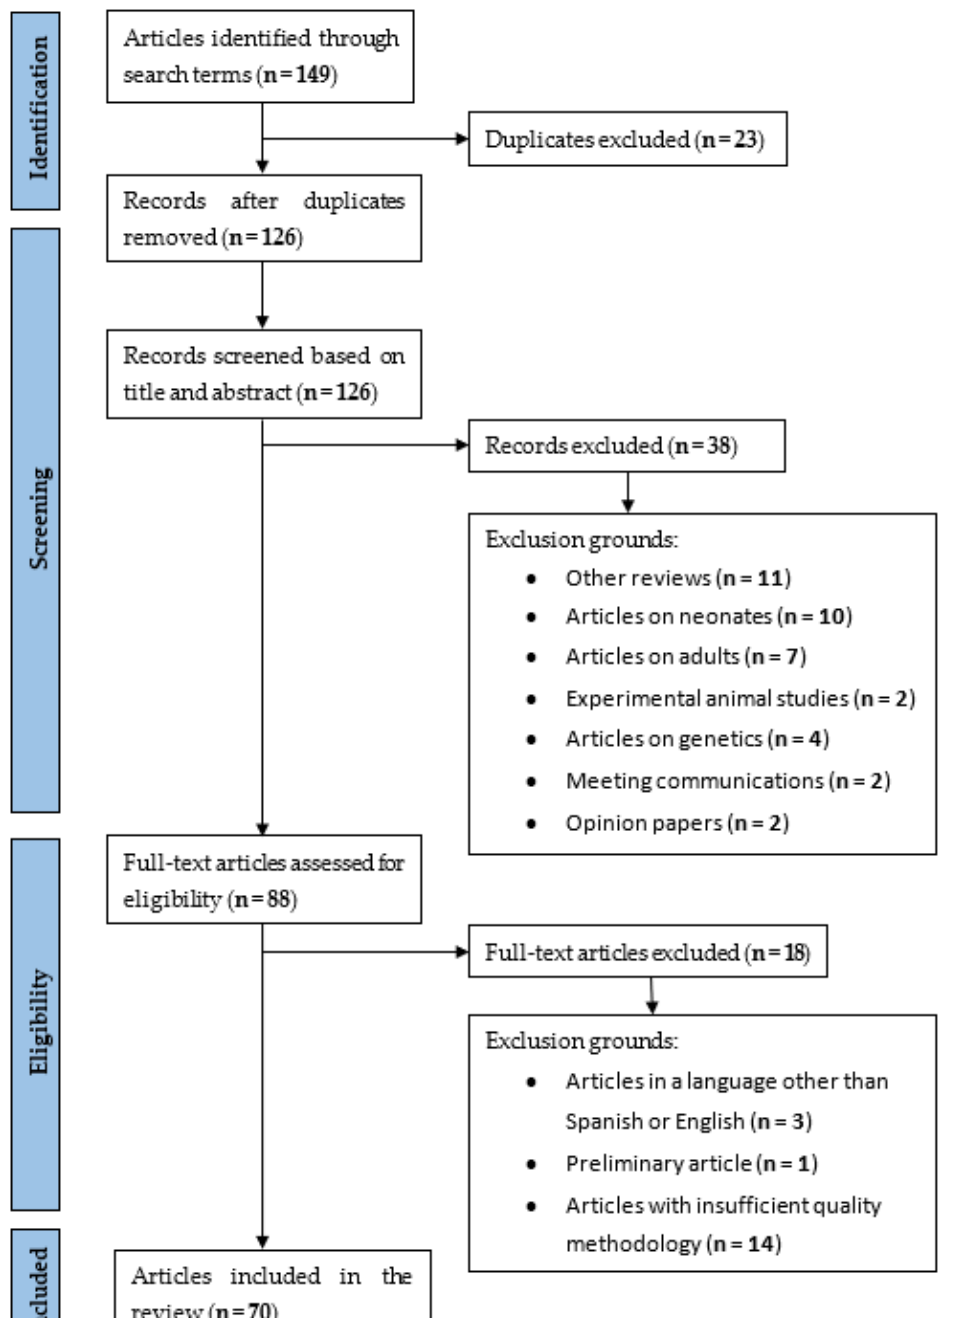
Figure 1. Flow Figure 1. Flow diagram.